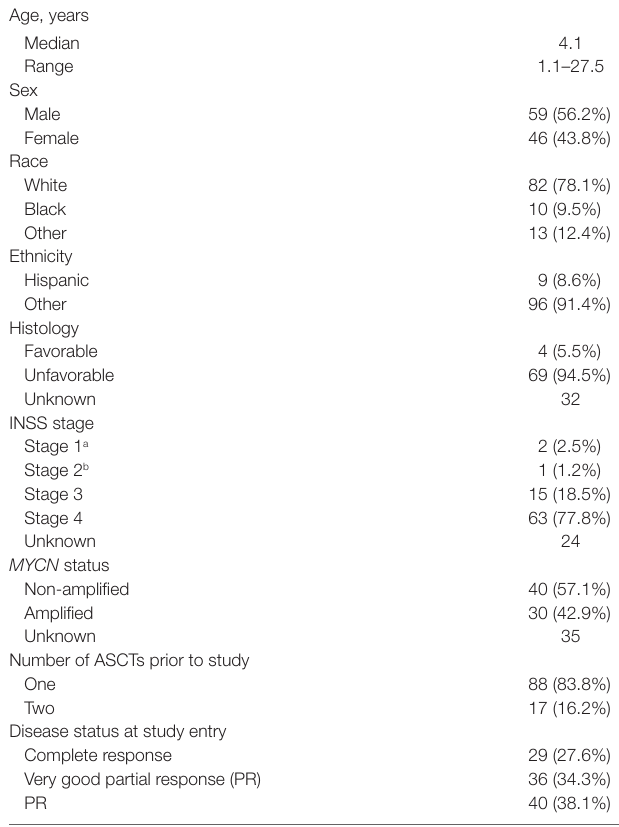
TaBlE 1 | Characteristics of patients enrolled on COG ANBL0931 ( n = 105).